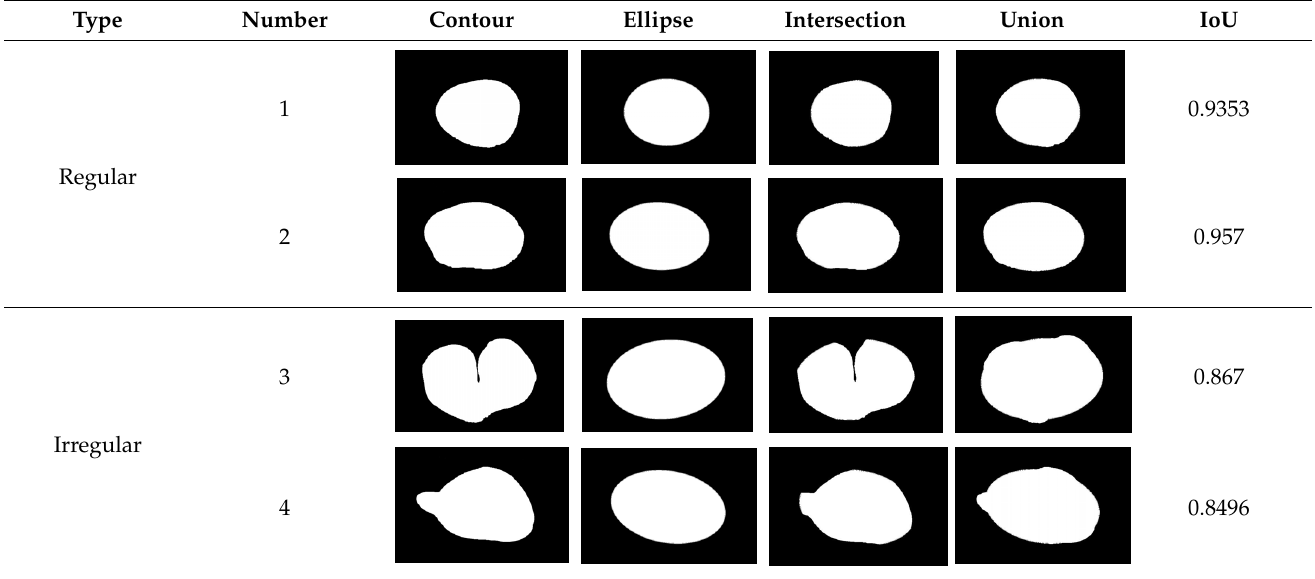
Table 3. IoU calculation results for regular and irregular potatoes.